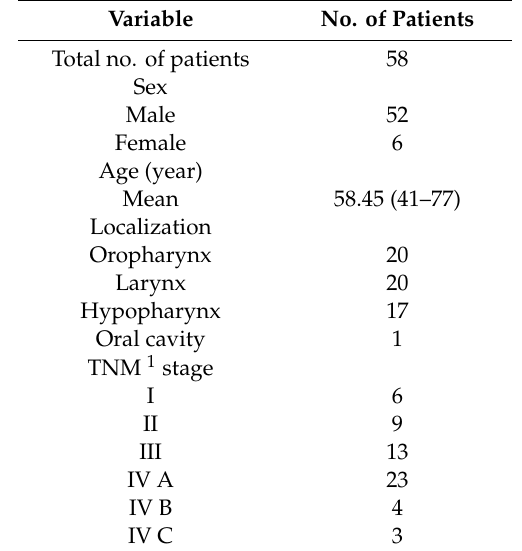
Table 2. Patient characteristics at time of